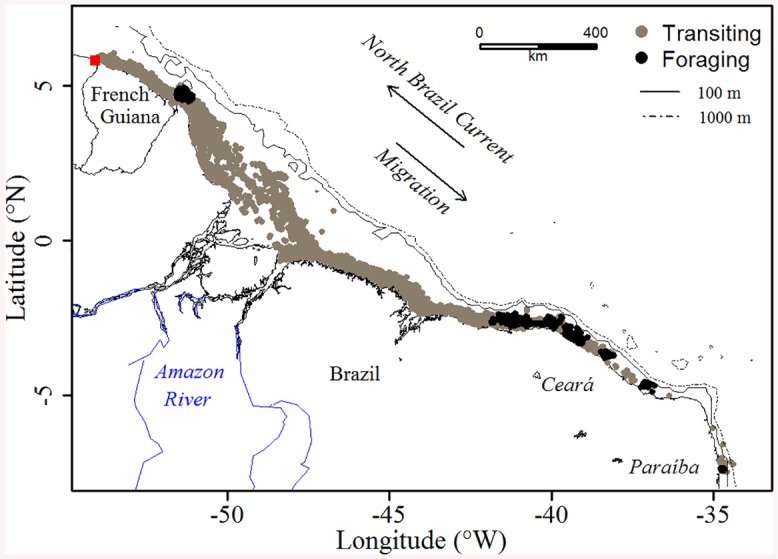
Locations of the 19 green turtles equipped in 2012 and 2014 for the two behavioral modes, i.e. transiting (gray) and foraging (black).The red square indicates the migration departure point. The shoreline was extracted from NOAA National Geophysical Data Center, Coastline.